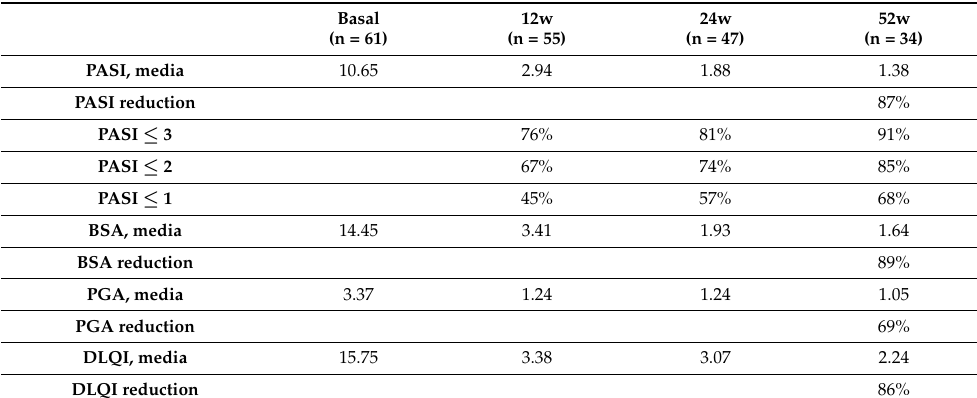
Table 2. Evolution of PASI, BSA andDLQI at the different time cut-off points.